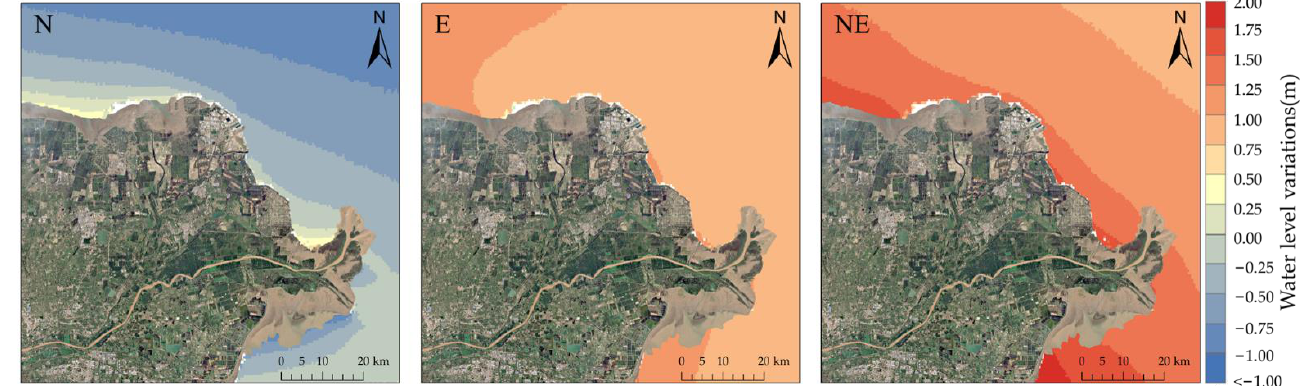
Figure 15. The YRD water level rises to control the 100-year winds in different